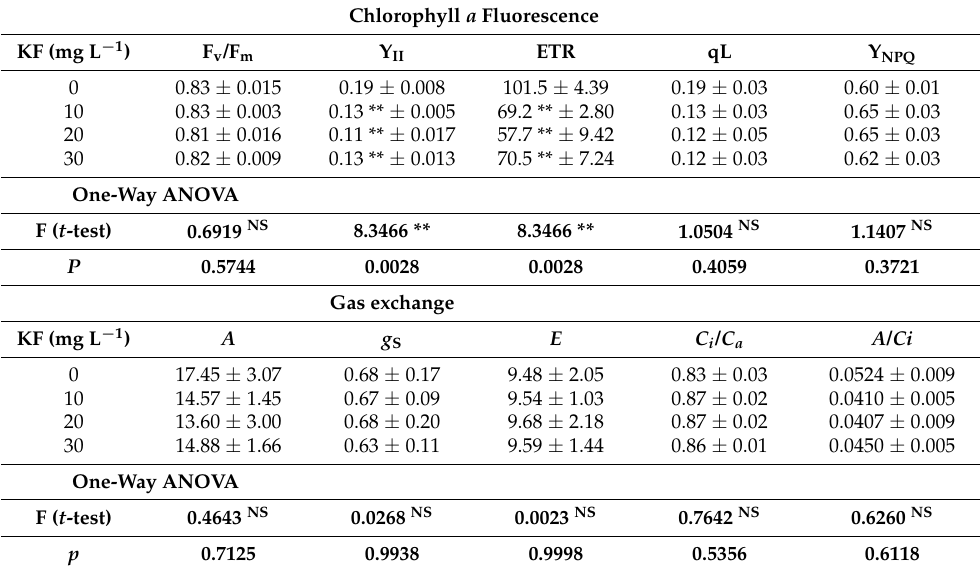
Table 2. Maximum photosystem II quantum yield (PSII) (F v /F m ), effective PSII quantum yield (Y II ), electron transport rate (ETR), photochemical extinction coefficient (q L ), quenching of regulated non- photochemical dissipation (Y NPQ ), photosynthetic rate ( A ), stomatal conductance ( g s), transpiratory rate ( E ), relationship between internal and external CO 2 concentrations ( C i /C a ), and carboxylation efficiency ( A/C i ) in Lactuca sativa L. plants after 40 days of exposure to 0 mg L − 1 , 10 mg L − 1 , 20 mg L − 1 , and 30 mg L − 1 potassium fluoride